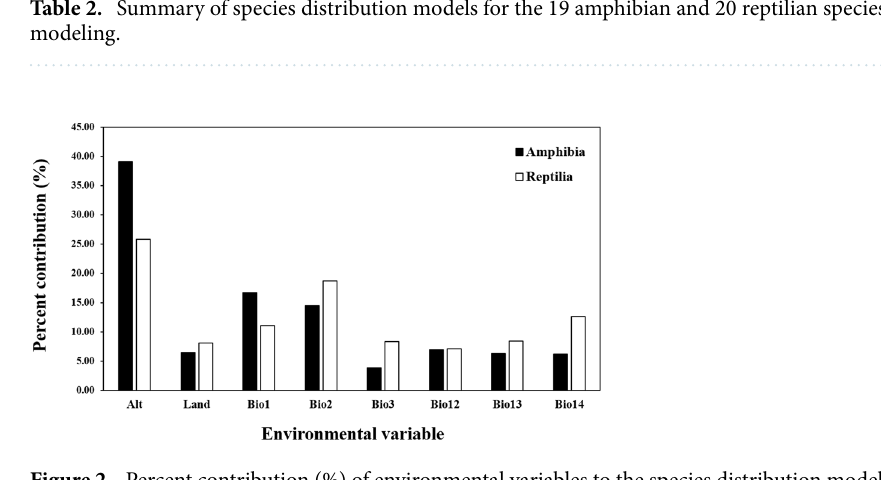
Figure 2. Percent contribution (%) of environmental variables to the species distribution model for the 19 amphibian and 20 reptile species. The percentage contribution shows the importance of variables determined by the jackknife test. Alt altitude (m), Land land cover, Bio1 annual temperature (°C), Bio2 mean diurnal range (°C), Bio3 isothermality (standard deviation × 100; °C), Bio12 annual precipitation (mm), Bio13 precipitation in the wettest period (mm), Bio14 precipitation in the driest period